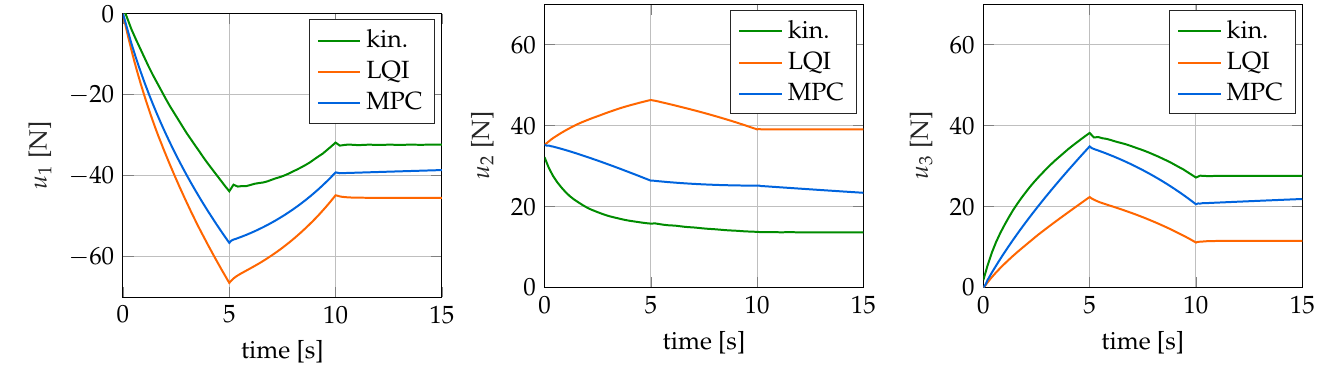
Figure 14. Reference trajectory as well as the tip position for different controllers for the L-shape trajectory over time.